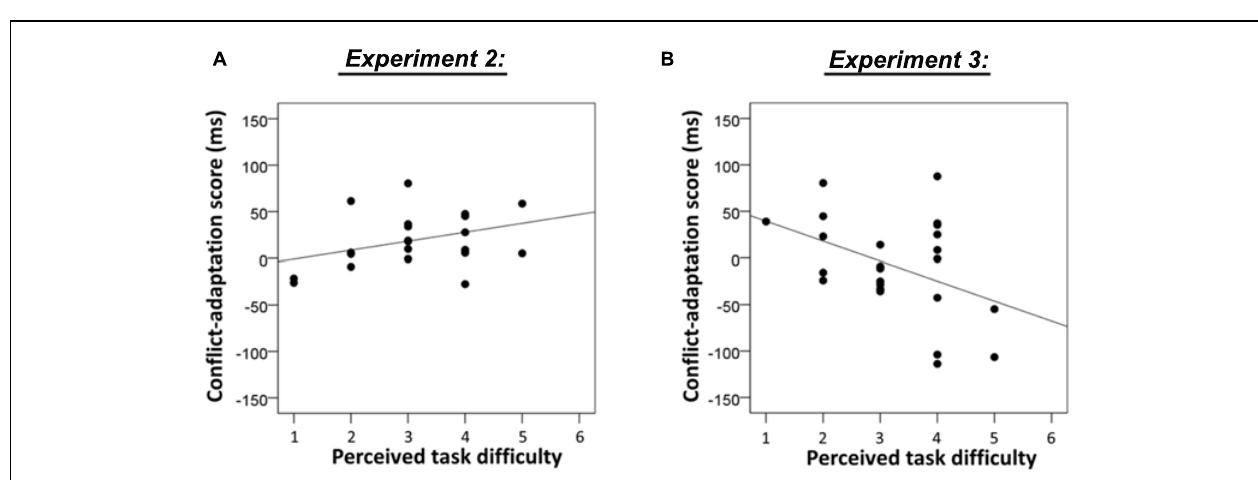
FIGURE 4 | (A) Association between individual task difficulty ratings and conflict-adaptation scores of the flanker task in Experiment 2. Note that this correlation is not significant ( p = 0.091). (B) Association between individual task difficulty ratings and conflict-adaptation scores of the flanker task in Experiment 3 ( p =